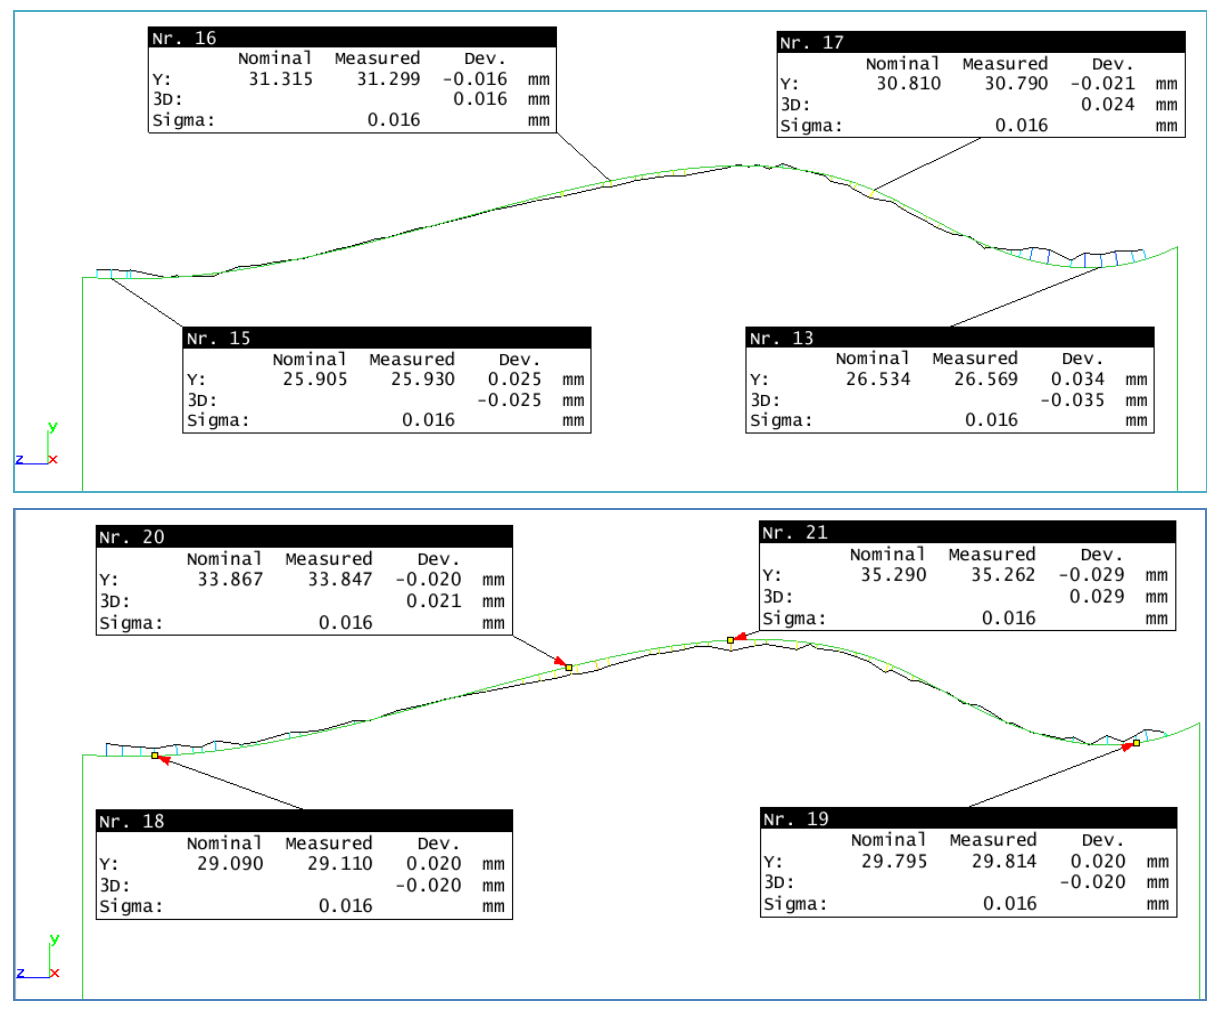
Figure 15. Evaluation of the deviations in the cross-section X=18 mm (above) and cross-section X=58 mm (below) EXP1